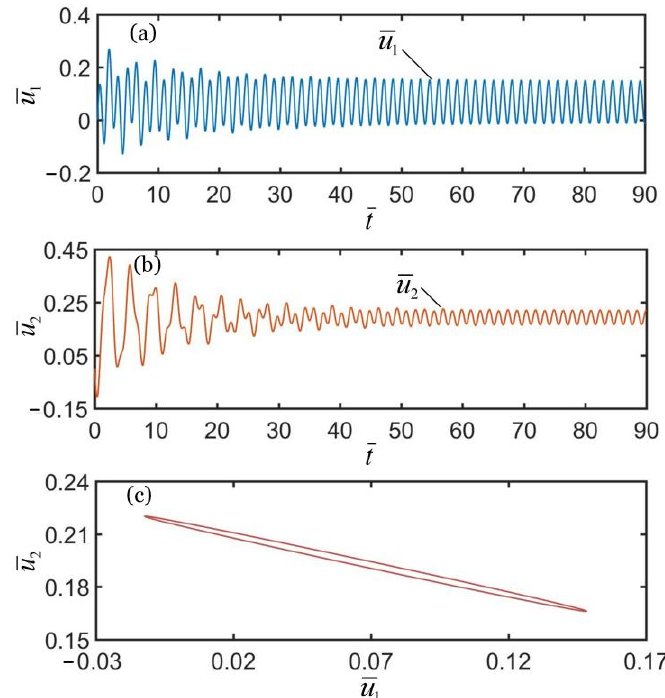
Figure 2. Time histories and domain of attraction of in-phase synchronous regime of light-powered = k vs. t ; ( c ) domain of at- LCE self-excited coupled oscillators for 16 2 traction. The two couple oscillators are in in-phase regime.